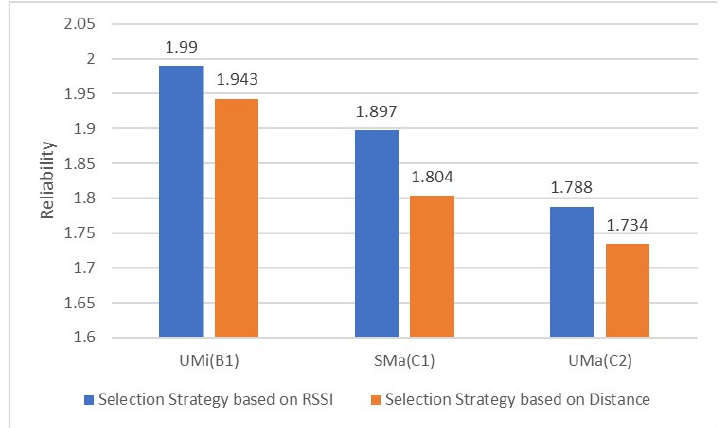
Figure 5. Comparison chart for simulation results under different